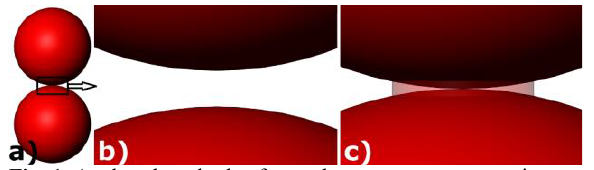
Fig. 1. Analysed methods of granules contact